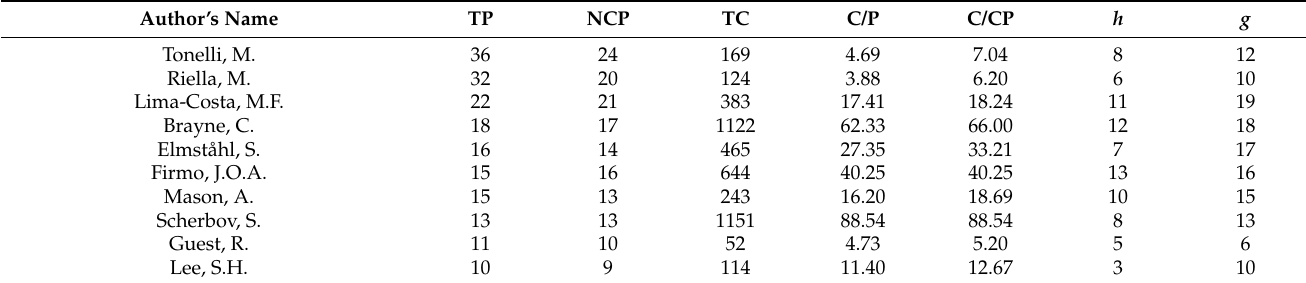
Table 4. Most productive authors.